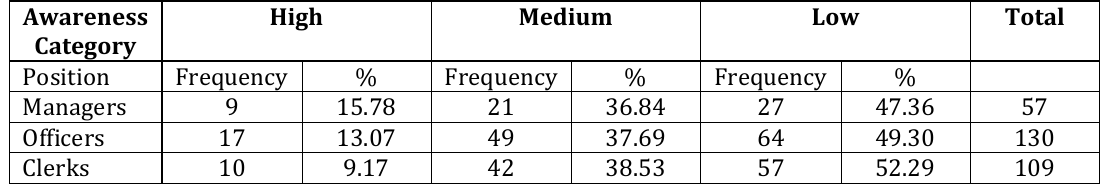
Table 8: Frequency Distribution of the Responses on the basis of Awareness Levels Awareness